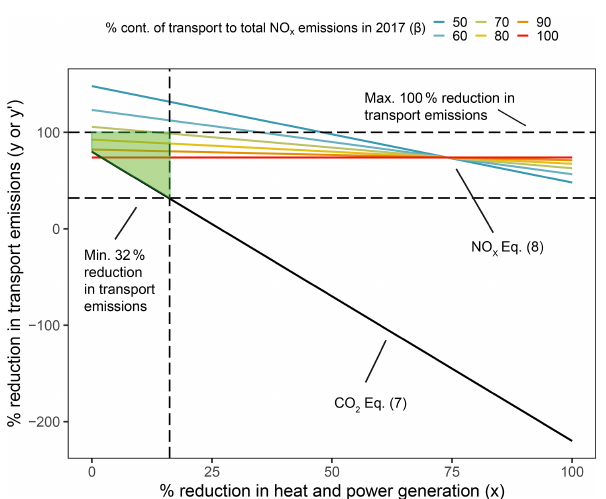
Figure 4. A plot showing the external constraints on NO x and CO 2 emissions. Equation (7) is shown as the solid black line, and Eq. (8) is shown as the coloured solid lines, with each colour reflecting a different value of β . The two horizontal dashed lines represent the two discussed constraints, and the vertical dashed line shows the constraint that the minimum reduction of 32% in traffic CO 2 emis- sions places on the NO x scenarios. All possible solutions when the constraints are applied are highlighted by the shaded green